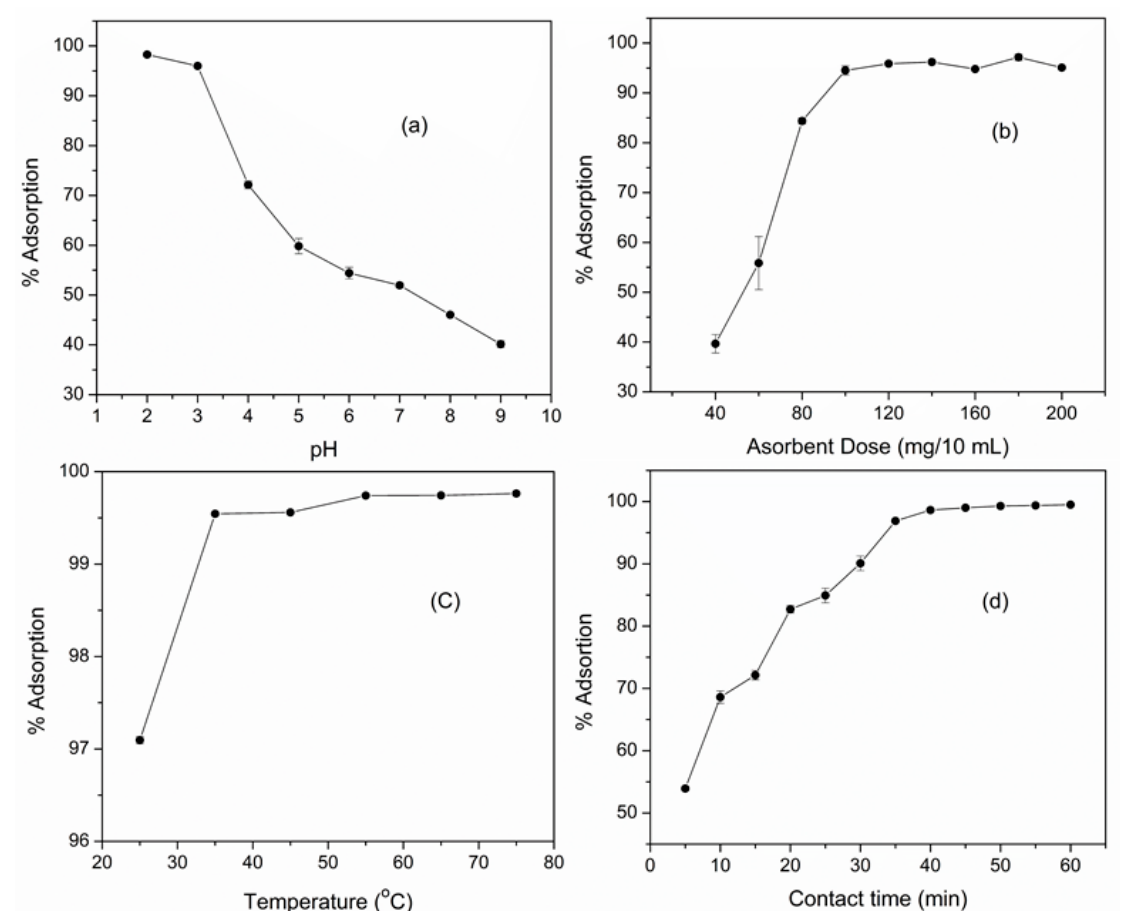
Figure 5. Effect of pH ( a ), adsorbent dose ( b ), temperature ( c ) and contact time ( d ) on the adsorption of Cr (VI) over M- AC.